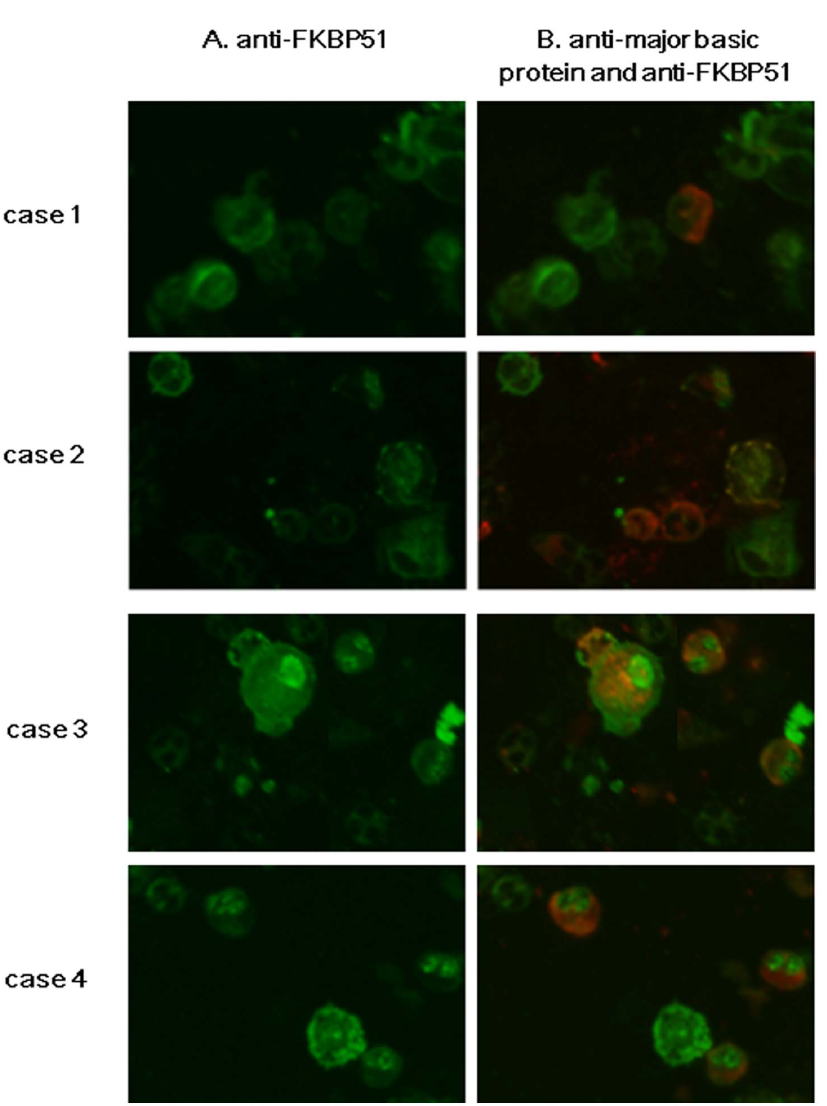
Figure 5. Representative images of immunostaining of sputum cells from asthmatic patients. Case 1 (68-year-old male) and case 2 (72- year-old female) were steroid-naı¨ve patients. Case 3 (79-year-old male) and case 4 (55-year-old female) were patients with severe persistent asthma on high-dose inhaled corticosteroid. Column A: staining with anti-FKBP51 antibody, column B: merged image of staining with anti-major basic protein antibody (MBP) and anti-FKBP51 antibody. Red indicates MBP, and green indicates FKBP51.